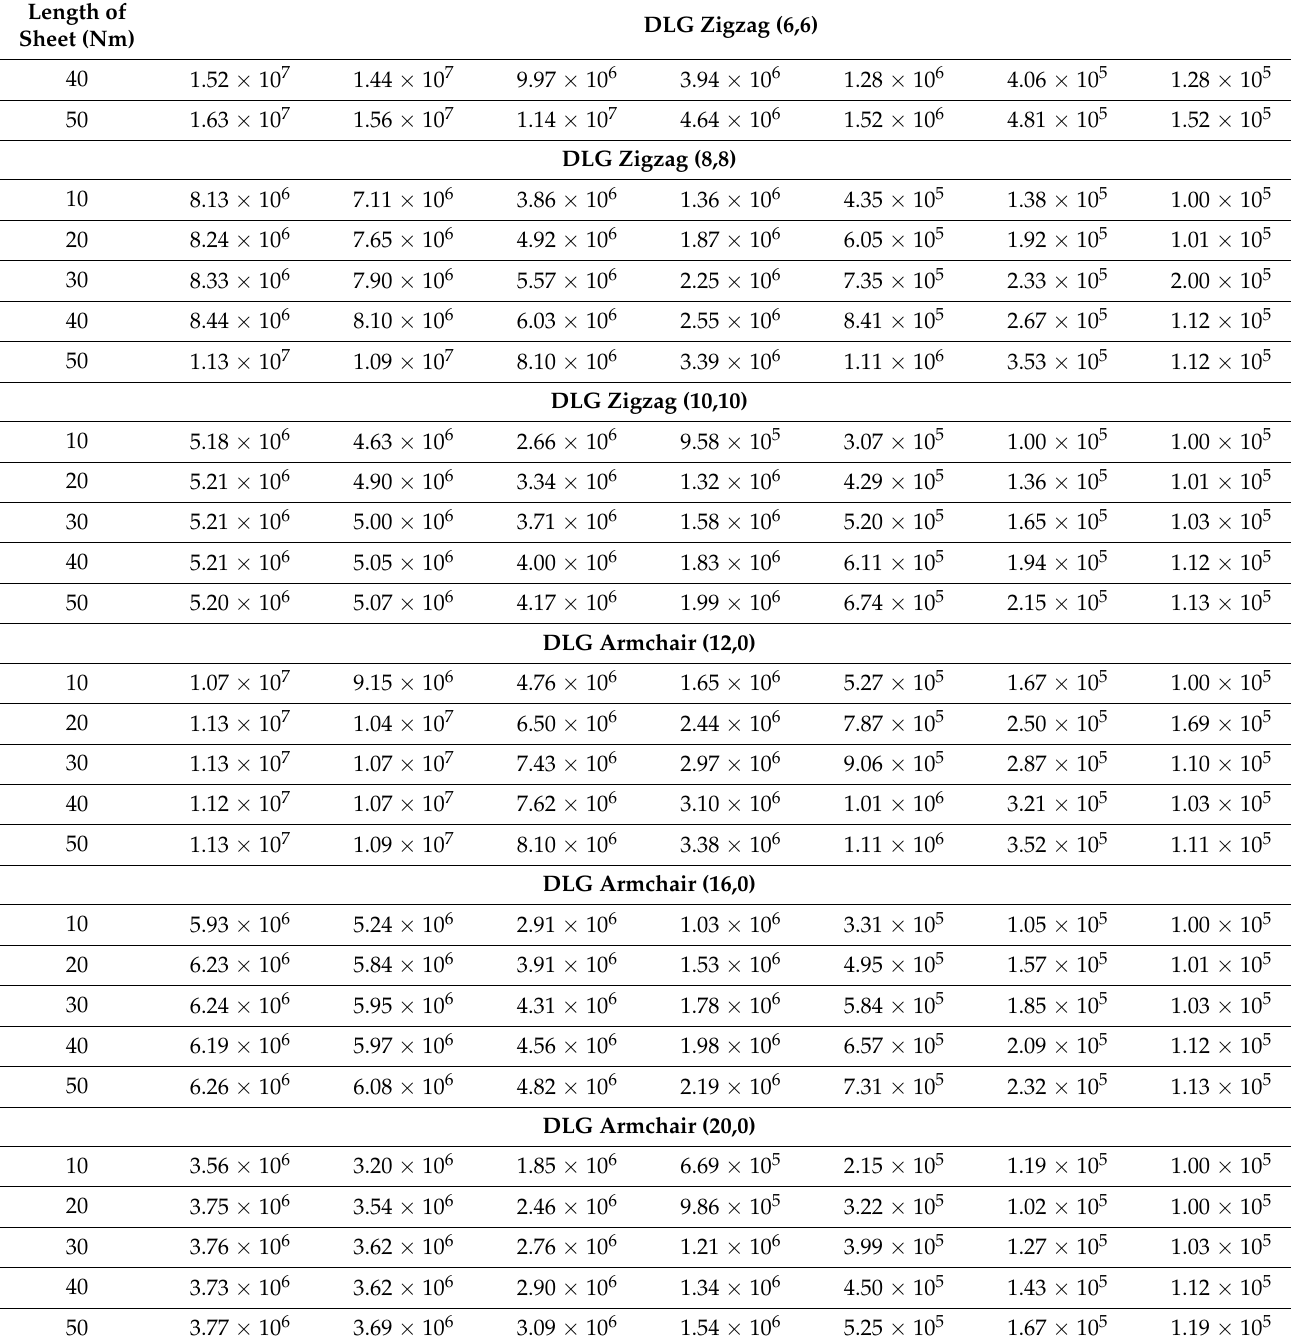
The frequency of the cantilever SLG fluctuates with length and chirality, as shown in Figure 5. The quantity of the frequency was found to be larger in the zigzag SLG (6, 6) for a sheet length of 50 nm and lower in the armchair SLG (20 0) for a sheet length of 50